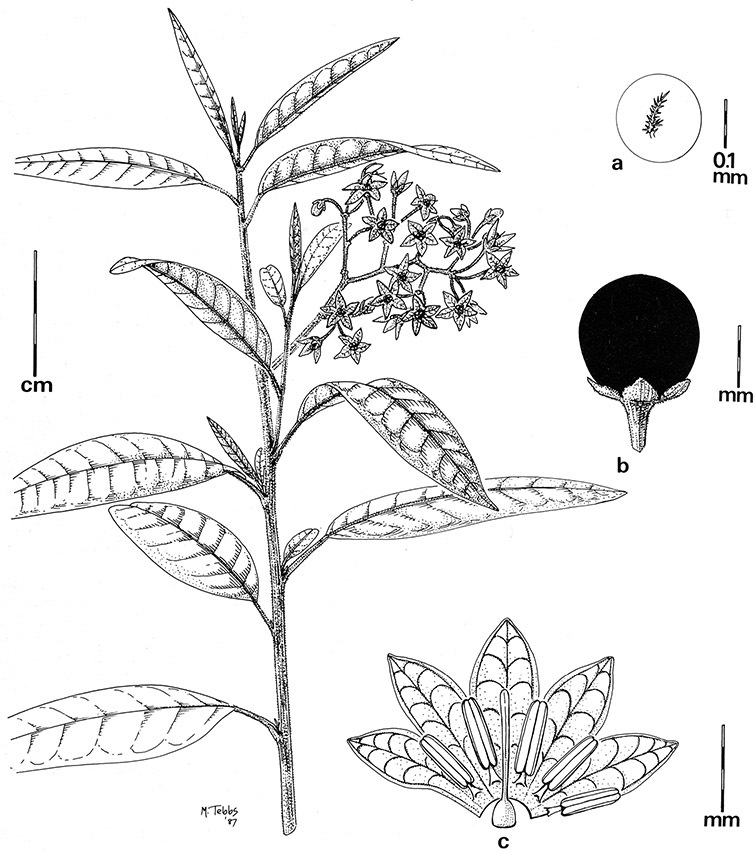
Solanum cutervanum Zahlbr. (drawn from Hutchison & von Bismarck 6571). Reproduced from Knapp (1989) with permission of the Natural History Museum Botany Library. Illustration by Margaret Tebbs.